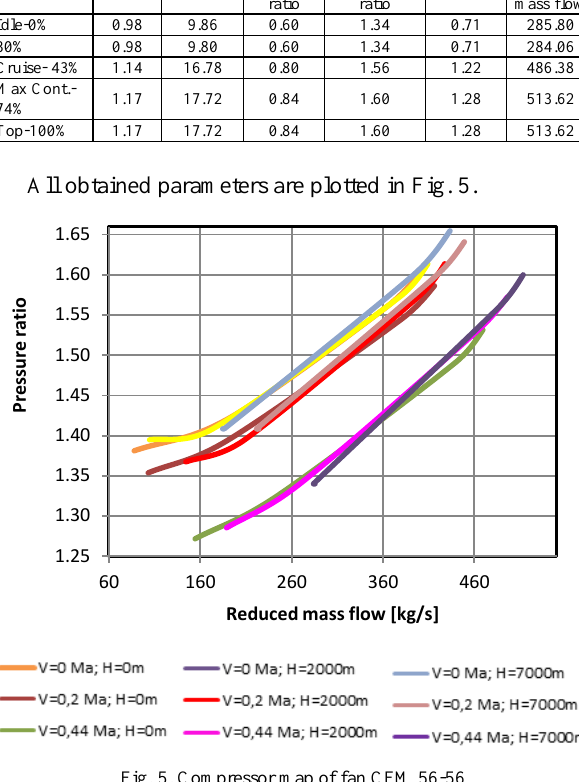
Table 12. Parameter of CFM 56-5B V = 0.44 Ma, H = 7000 m Pressure ratio